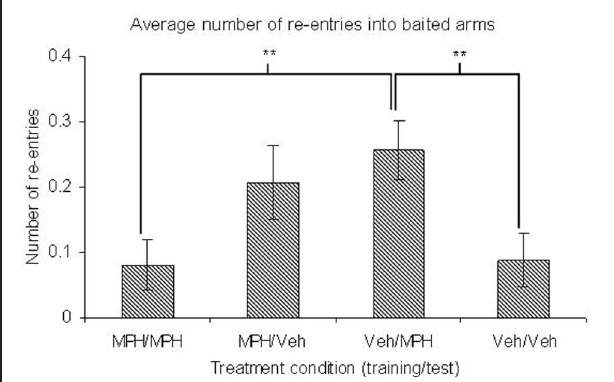
FIGURE 6 | With performance on the 3h DSWT as a fixed covariate, an ANCOVA showed there are no significant differences in the number of baited re-entries between groups given methylphenidate (MPH) or vehicle (Veh) in both phases on the 6h delay. However, giving methylphenidate in just one phase increases the number of errors. When methylphenidate is given only in the test phase, this increase is significantly different from groups given the same treatment in both phases. All graphs show mean ± SEM. ∗∗ p = 0 . 01.